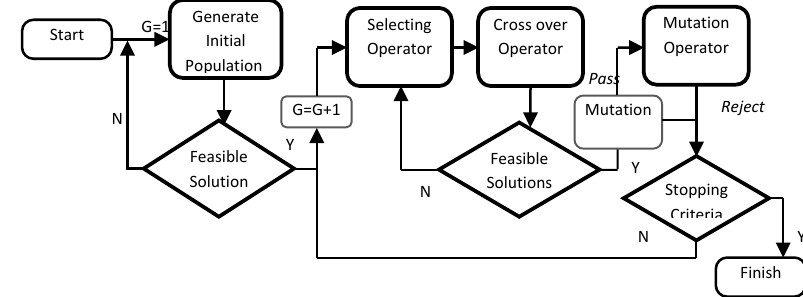
Fig. 2. Structure of the Proposed GA-based